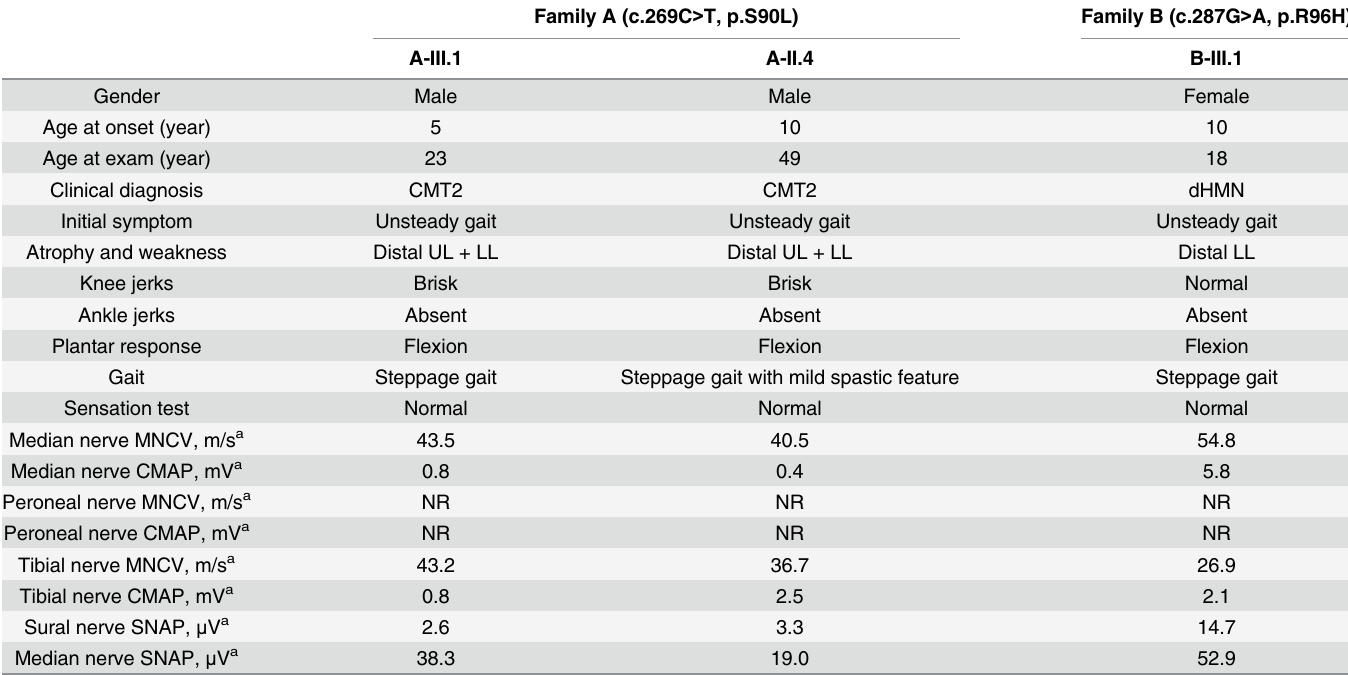
Table 2. Clinical and electrophysiological features of the patients with BSCL2 mutations.